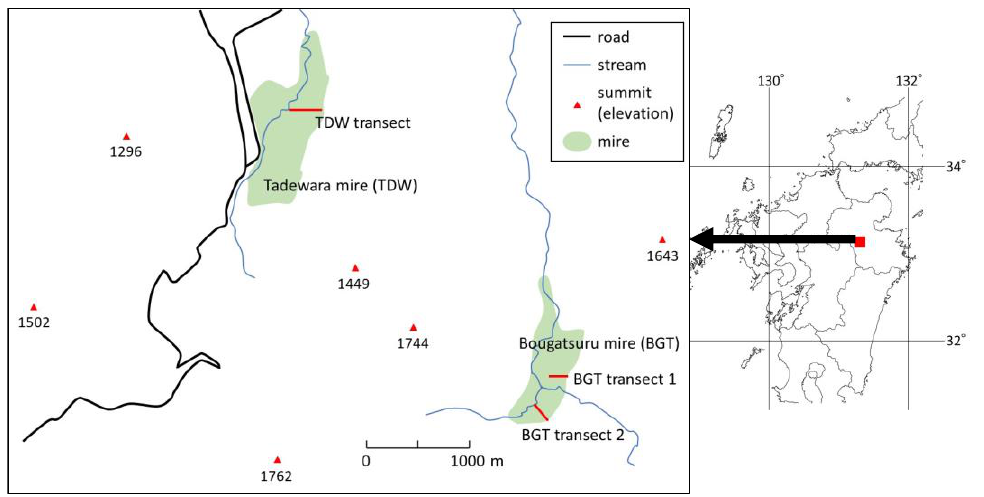
Figure 1. Map showing the Tadewara mire (TDW) and Bougatsuru mire (BGT) in south-western Japan. TDW transect, BGT transect 1, and BGT transect 2 are investigated transects with a length of 160 m, 70 m, and 90 m, respectively.